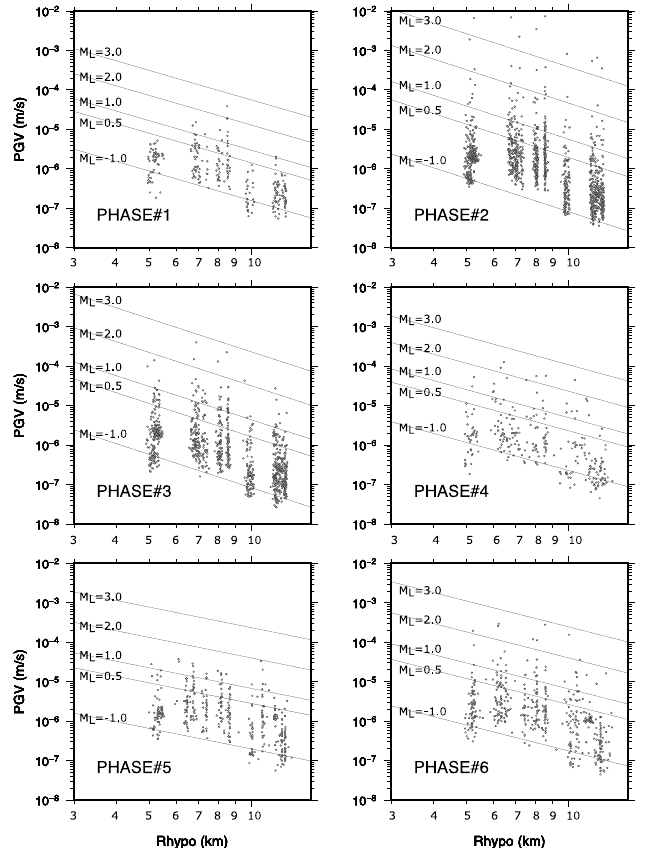
Figure 3. Peak-ground velocities ( PGVs ) as function of the hypocentral distance for each of the six phases of the project analyzed in the present study. In each panel, the continuous lines refer to the GMPEs whose coefficients are listed in Table 1 evaluated for 𝑀 (cid:3013) = − 1.0, 0.5, 1.0, 2.0 and 3.0.